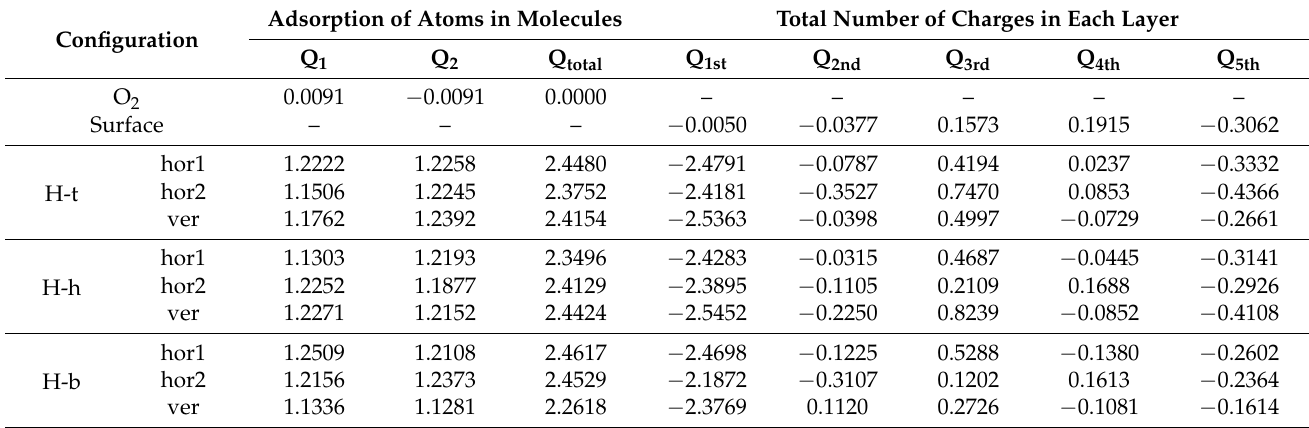
Table 2. Net charge distribution after optimization of each adsorption